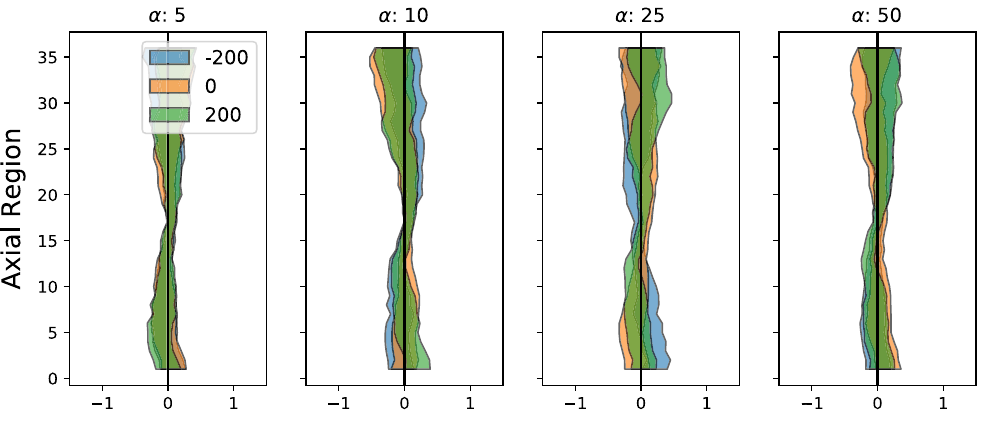
Figure 5: TF-XE (power): Relative difference (%) with reference after final iteration